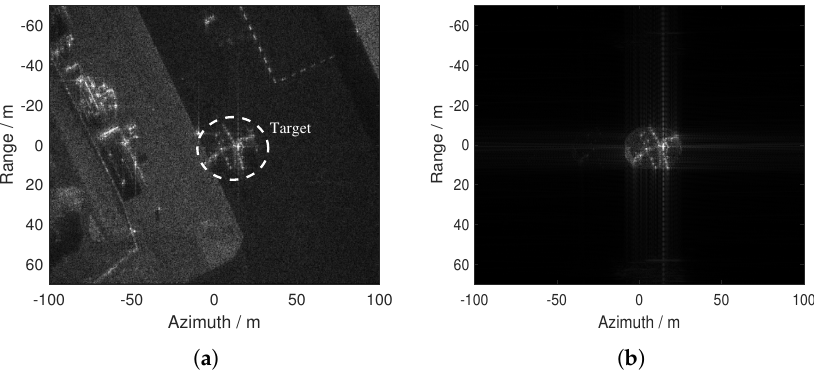
Figure 7. Original synthetic aperture radar (SAR) scene. ( a ) The original image. ( b ) The